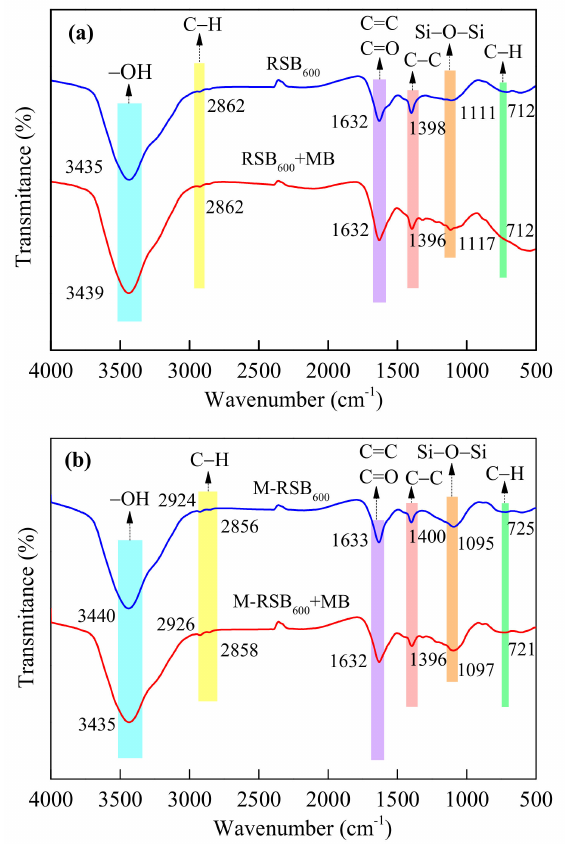
Figure 14. FTIR spectra of RSB 600 ( a ) and M-RSB 600 ( b ) before and after MB